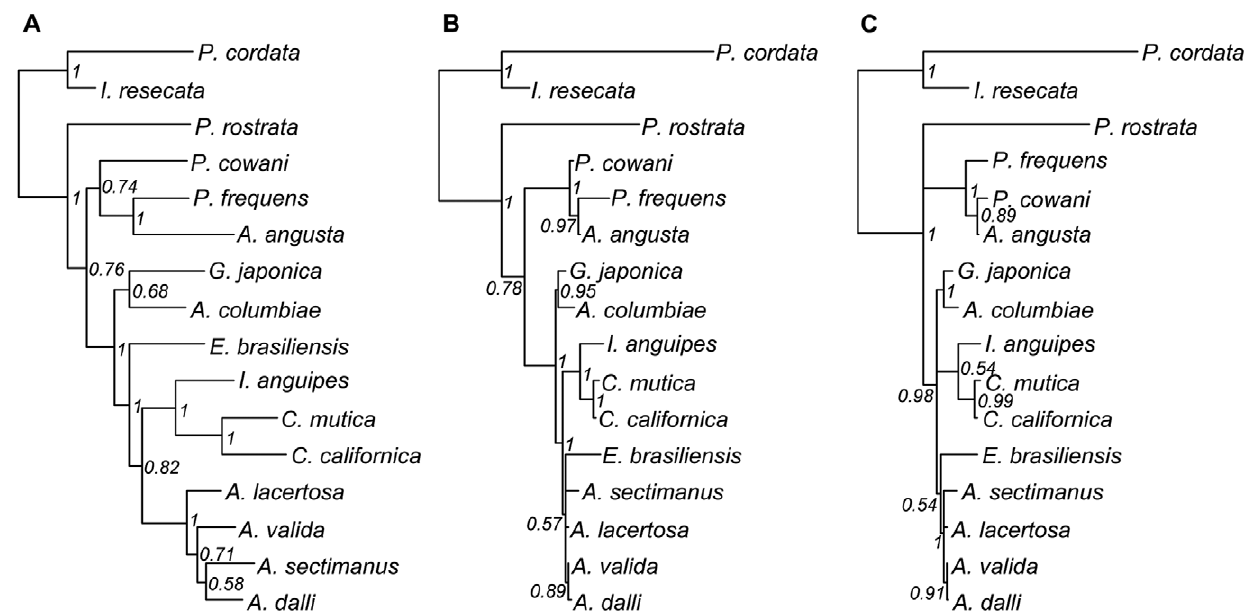
Figure 3. Comparison of phylogenies obtained for the 16 Bodega Bay species. A) mitochondrial gene tree (COI and 16S), B) nuclear gene tree (18S), C) topology for Bodega Bay species extracted from the 88 species 18S tree shown in Figure 2. All trees are 50% majority rule consensus trees from MrBayes analyses, with the node labels giving posterior probabilities. For full species names see Figure 1 (note that multiple genera with the same initial letter are abbreviated here). The only conflict between these topologies is within the Talitroidea ( Protohyale frequens , Parallorchestes cowani , and Allorchestes angusta ). However, the alternate topology obtained in the 88 species analysis is not well supported; the posterior probability=0.89, where strong support is typically . 95% for posterior probabilities (rather than . 70% for bootstrap probabilities